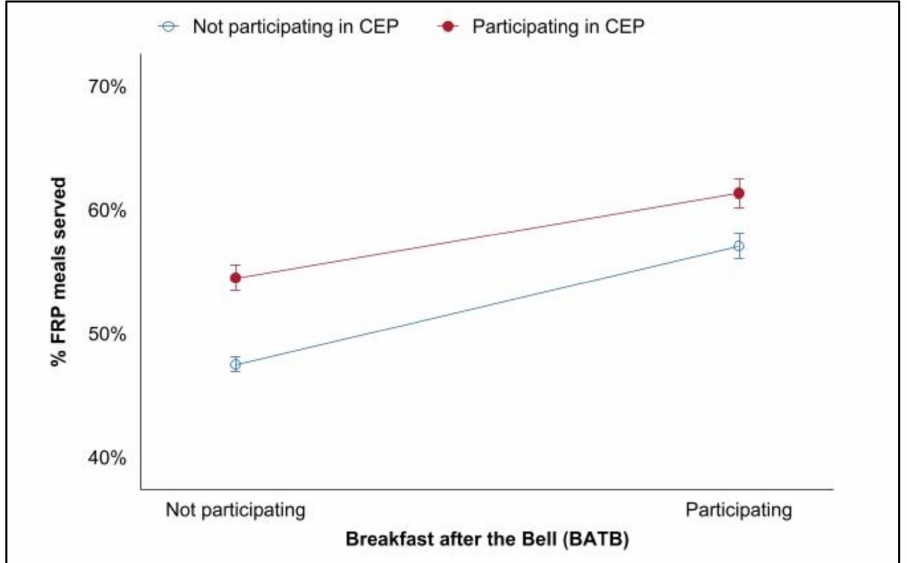
Figure 5. Impacts of CEP and BATB on FRP breakfast provision.